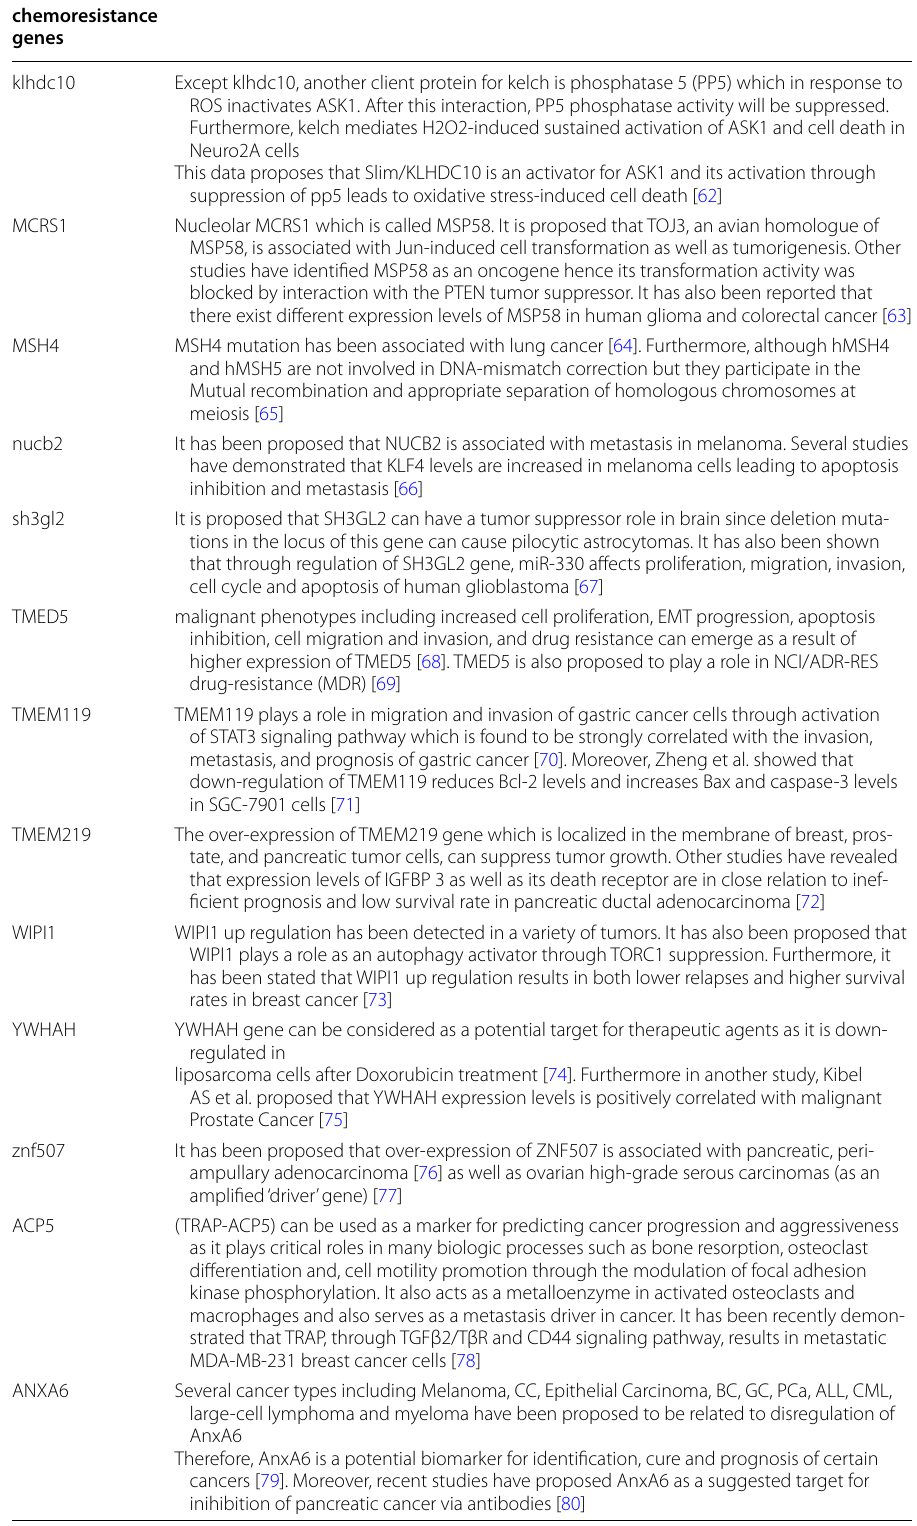
Table 8 potential chemoresistance genes proposed for further studies Potential Main role in chemoresistance genes